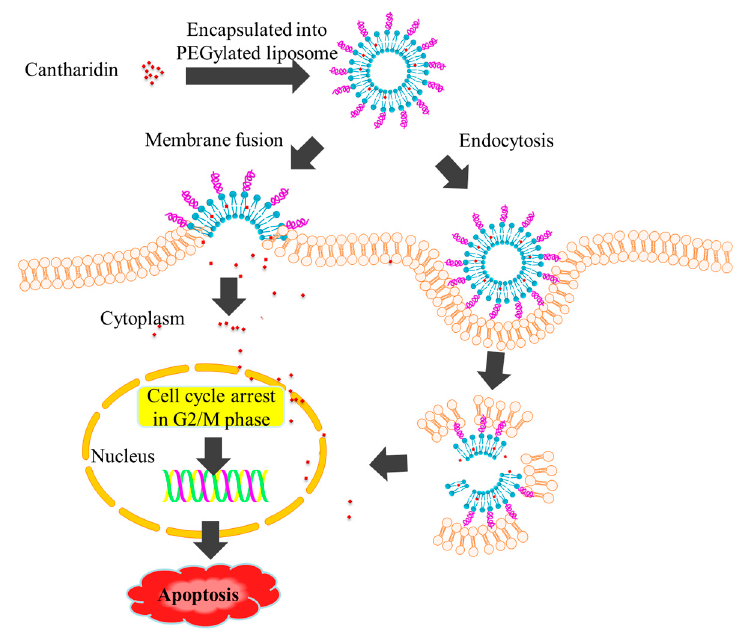
Figure 6. Proposed mechanisms of better anticancer effect of liposomal cantharidin.